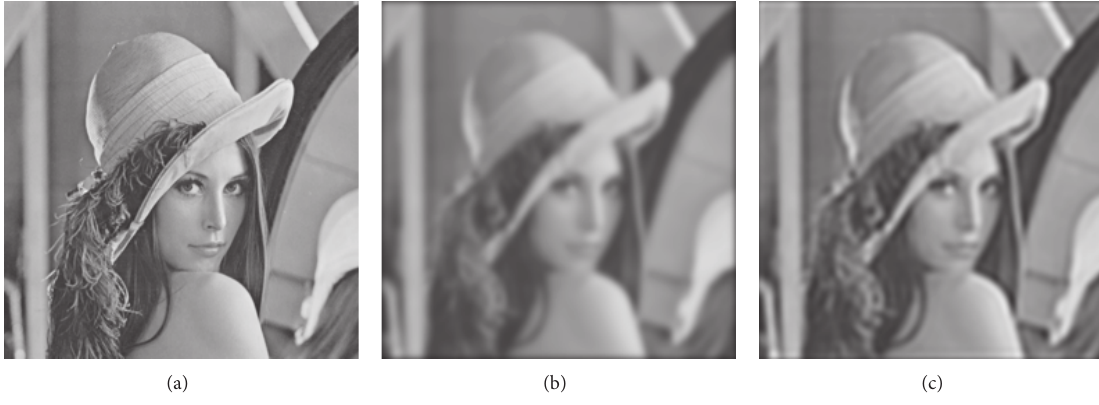
Figure 1: (a) The original image. (b) The noisy image. (c) The recovered